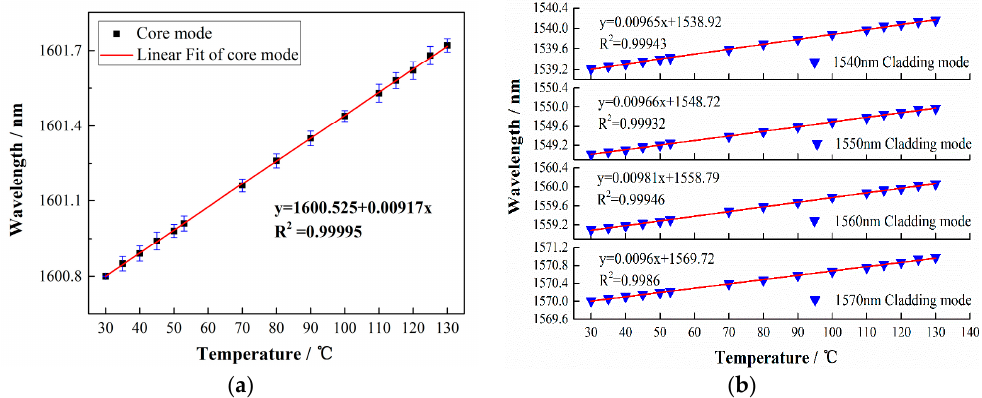
Figure 3. ( a ) The linear fit of wavelength response of the core mode under different temperatures. A 12° TFBG with a 1.6 μ m coating was used. ( b ) The linear fit of cladding modes wavelength responses to temperature, including the cladding modes near 1540 nm, 1550 nm, 1560 nm, and 1570 nm.